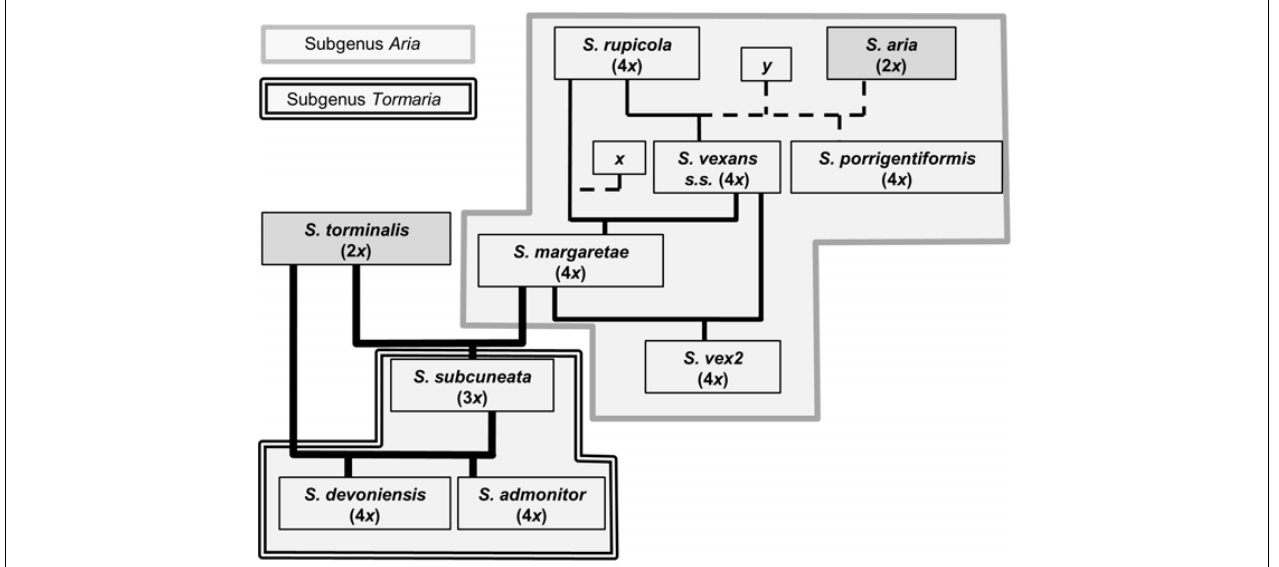
FIGURE 6 | Proposed relationships among Sorbus species sampled from southwest Britain. Ploidy levels, as determined by FCM, are given in parentheses. Line weight indicates approximate strength of supporting evidence. Dashed lines indicate speculative relationships and ‘ x ’ and ‘ y ’ indicate possible missing intermediate genotypes or indirect